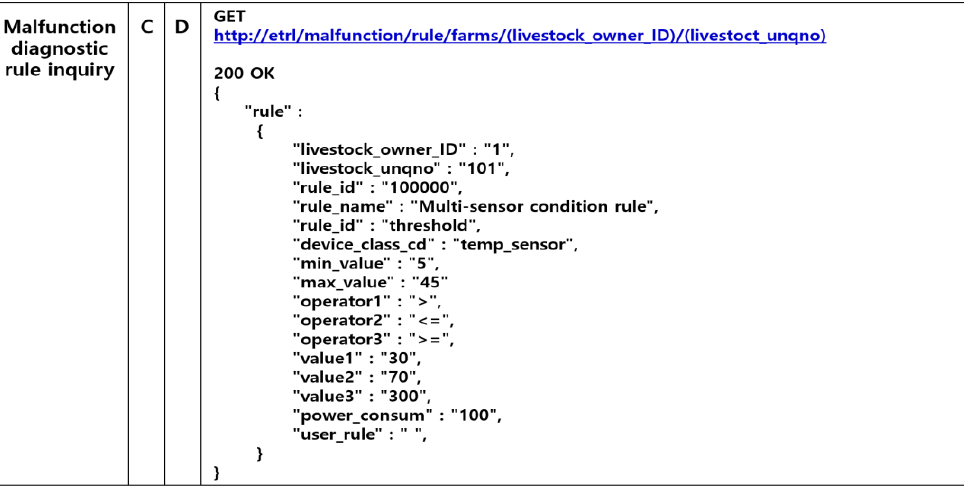
Figure 7. Figure 7. Items of the inspection interface that define the rules for malfunction detection in individ- ual devices.